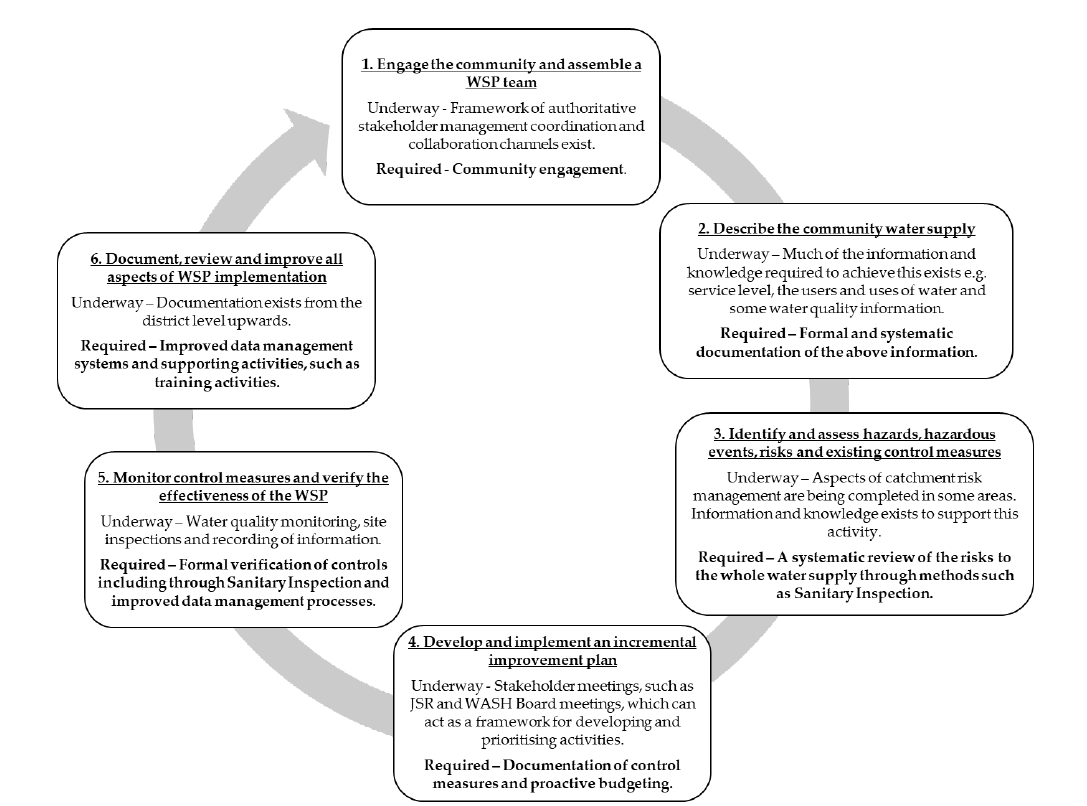
Figure 3. The six steps involved in a community WSP [11], the related activities occurring in Rwanda which could support the implementation of WSPs and gaps in existing tasks which require addressing to fulfil WSP guidance.